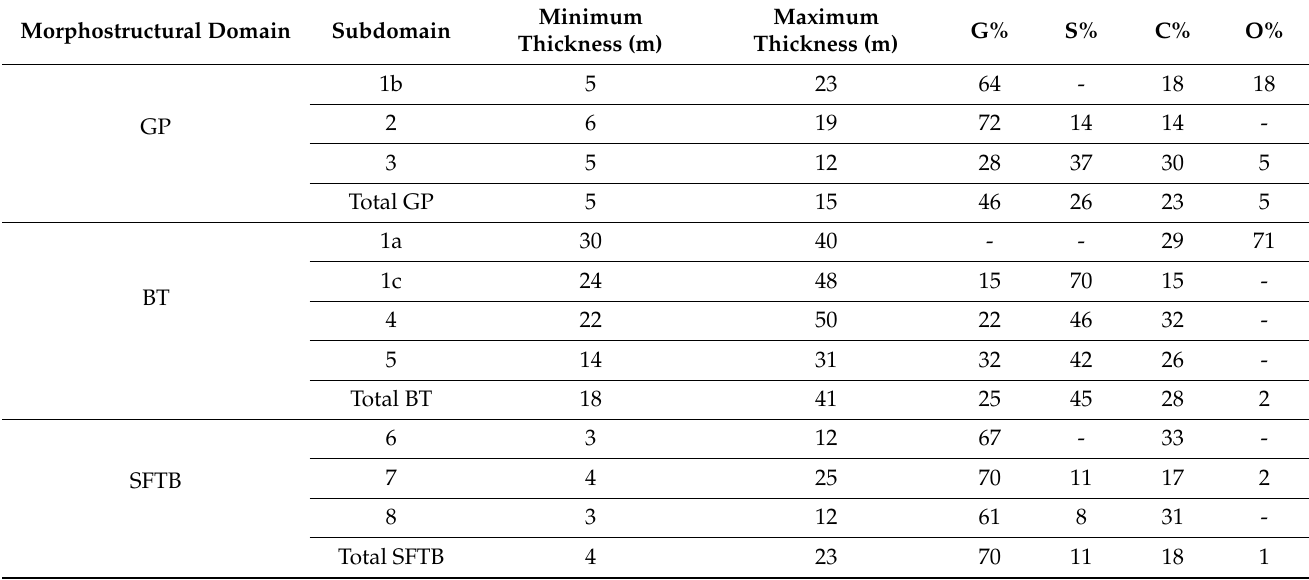
Table 2. Minimum thickness, maximum thickness and distribution in terms of percentage of the cover terrains for each of the three morphostructural domains and for the eight subdomains. Values in the rows named as “Total” were obtained by computing a weighted average, where the weight corresponds to the number of sites where the cover terrain characteristics were estimated within each